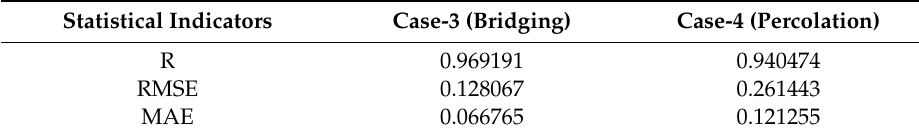
Figure 9. Simulated fine fraction variation by the depth in comparison with Gibson measurement [42]. ( a ) Bridging and ( b ) percolation. Table 4. Verification of Fine Sediment Distribution with Gibson’s Measurement [ 42 ].